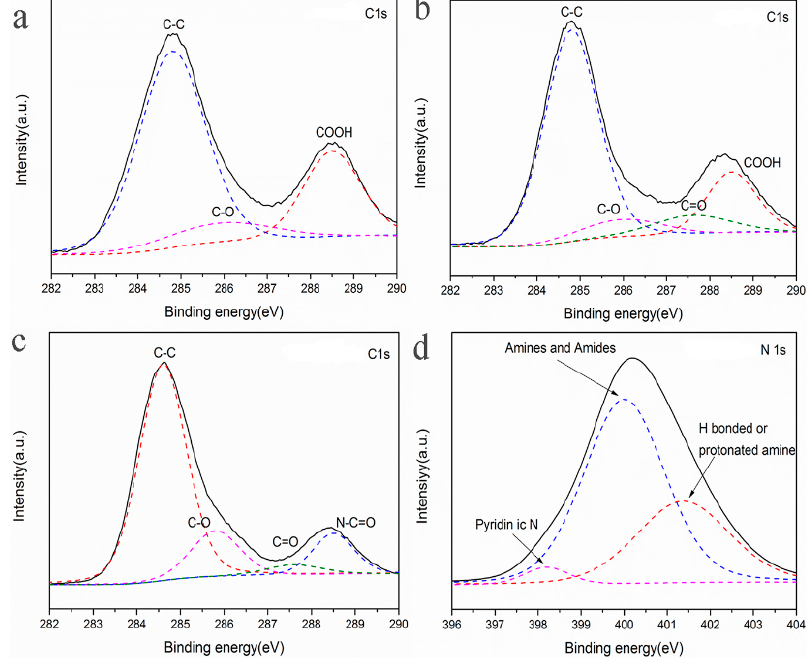
Figure 3. High-resolution XPS spectra of as-synthesized carbon nanomaterials in this work: ( a ) Carbon nanomaterials-1; ( b ) Carbon nanomaterials-2; ( c , d ) Carbon nanomaterials-3. FT-IR spectroscopy (Figure S1) reveals the existence of O-H in different carbon nanomaterials, which can be seen from the obvious peak at 3650 cm − 1 . The peak at 3000 cm − 1 corresponds to the carboxyl group, and the peak at 1724 cm − 1 in the spectrum of Carbon nanomaterials-2 is from